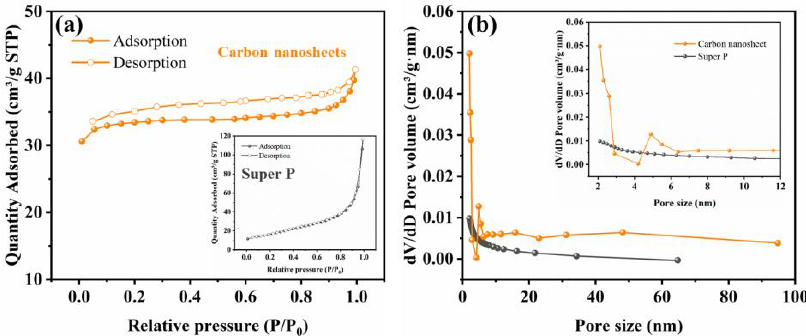
Figure 4. N 2 adsorption-desorption isotherms ( a ) and the pore size distribution ( b ) of the as-synthesized carbon nanosheets and Super P.